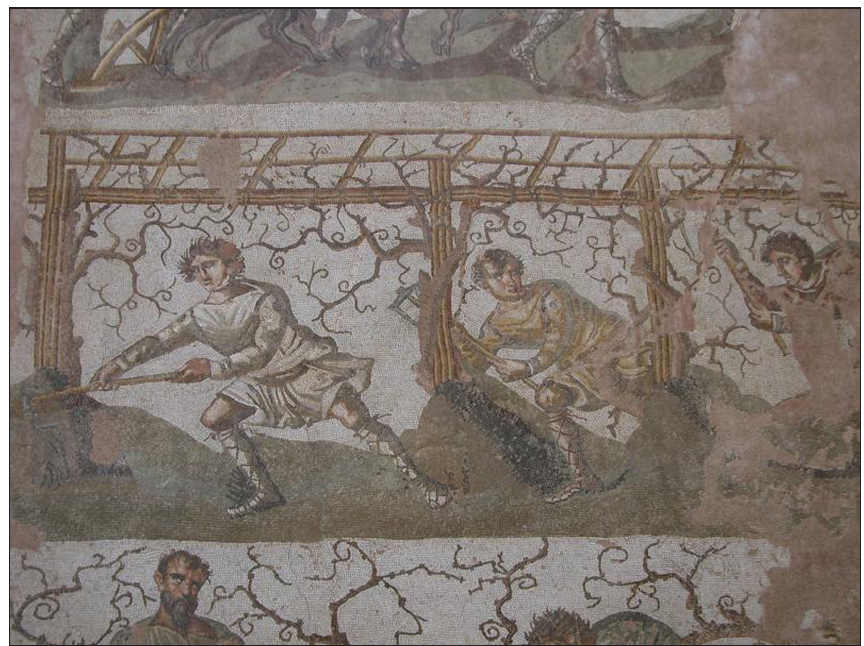
Figure 5: Cherchell Mosaic, men collecting grapes. (Photo: Yves Jalabert, licensed under Creative Commons Attribution-Share Alike 2.0 Generic